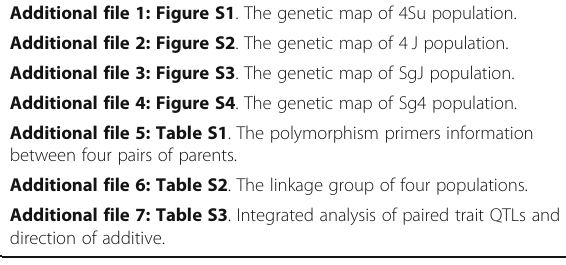
Additional file 1: Figure S1 . The genetic map of 4Su population. Additional file 2: Figure S2 . The genetic map of 4 J population. Additional file 3: Figure S3 . The genetic map of SgJ population. Additional file 4: Figure S4 . The genetic map of Sg4